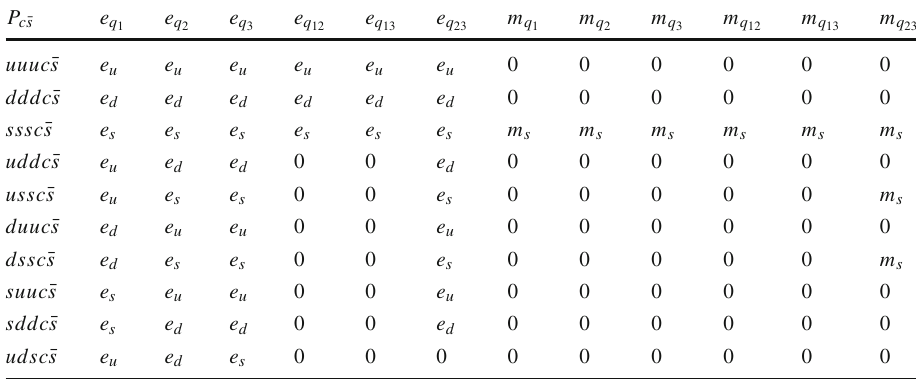
Table 2 The values of e q m q and m q related to the i ij expressions of the electromagnetic form factors in Eqs.